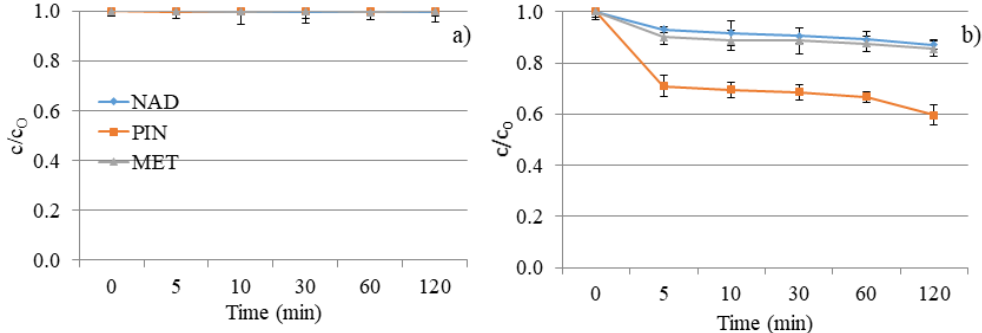
Figure 12. NAD, PIN, and MET mixture degradation kinetics under UV irradiation: ( a ) without V 2 O 5 and ( b ) with V 2 O 5 catalyst.